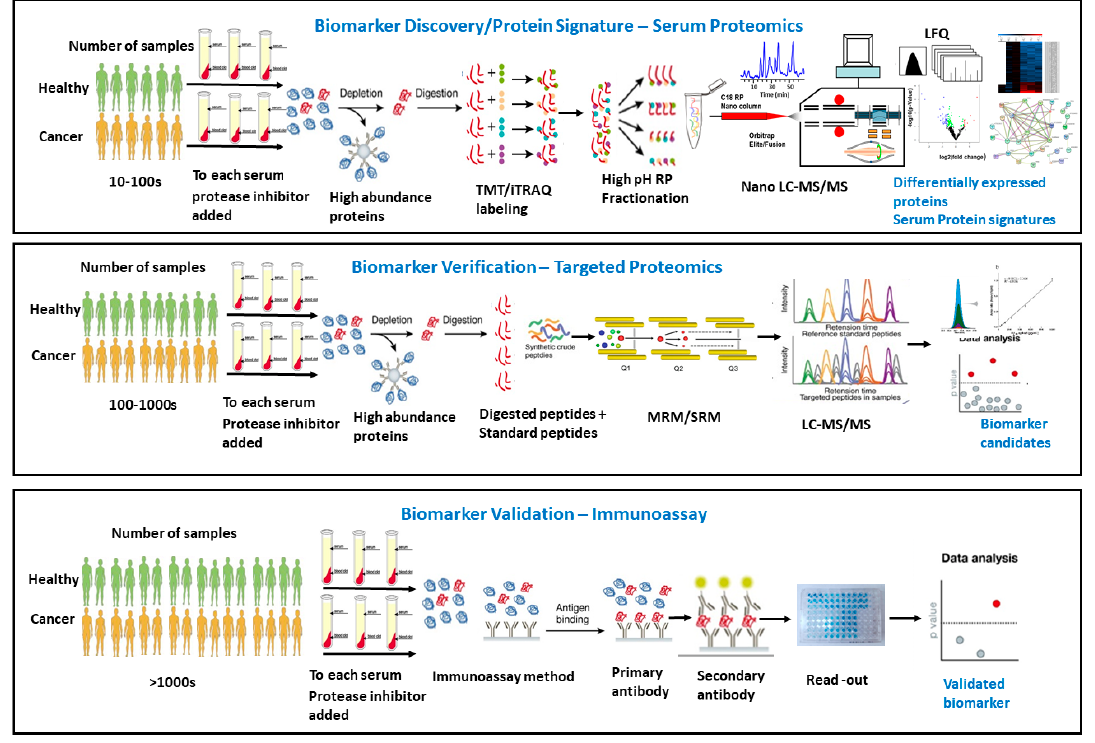
Figure 1. Current serum proteomics workflows for the discovery, verification, and validation of cancer biomarkers. Top panel: global comparative serum proteomics workflow for screening some candidates of protein signature from tens/hundreds of differentially expressed proteins found between healthy and cancer patients. Middle panel: targeted quantitative serum proteomic workflow in a larger number of samples for verifying potential biomarker candidates. Bottom panel: the development of an immunoassay for selected potential biomarkers for validation and clinical application.